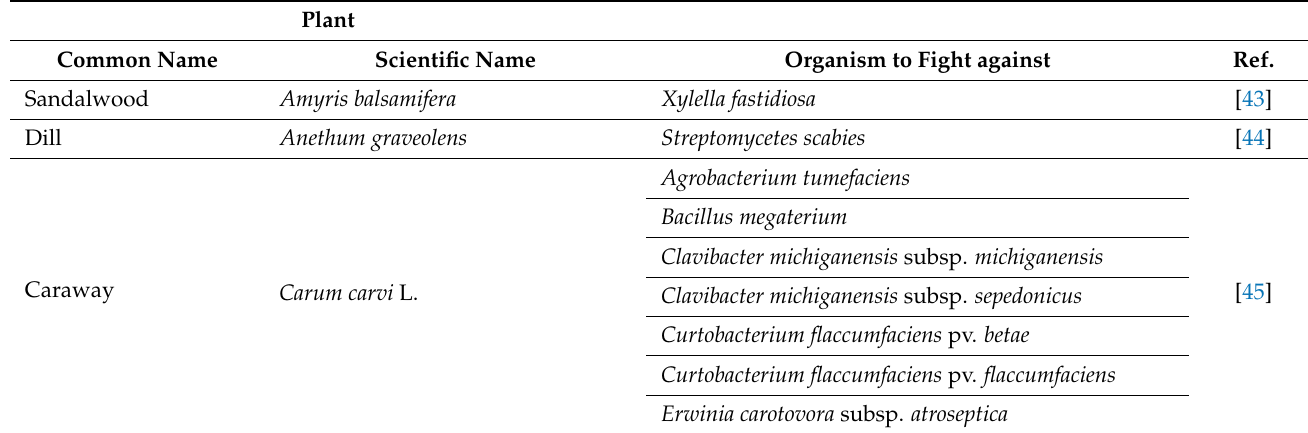
Table 1. Plants that present essential oils that could be used for their antibacterial properties.